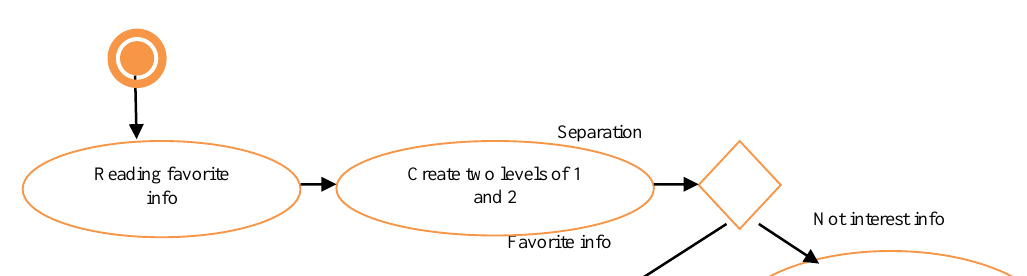
Figure 15. Capability model of the classification agent.